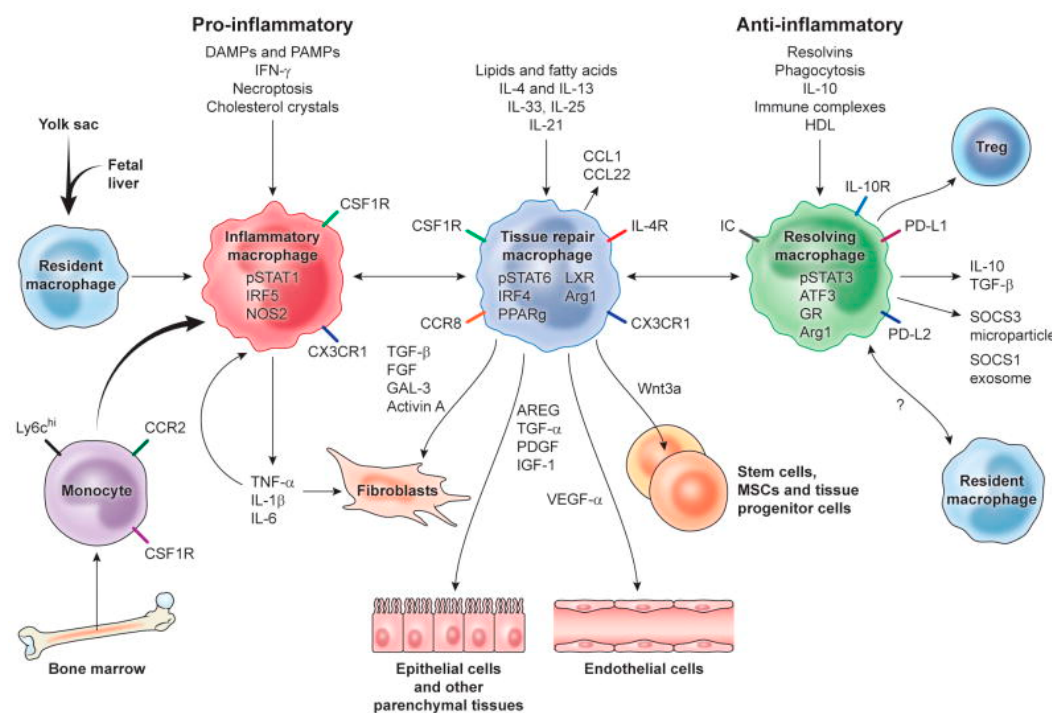
Figure 3. Mechanisms of major macrophage activation phenotypes in tissue repair, regeneration, and fibrosis. Tissue- resident and recruited macrophages have phenotypic and functional changes when biological factors are released in the local tissue microenvironment. M2 phenotype macrophages (green) can produce various biological processes to stimulate cell proliferation, differentiation, and activation, in order to promote tissue repair. Reprinted with permission from ref. [40]. Copyright 2021 Elsevier.